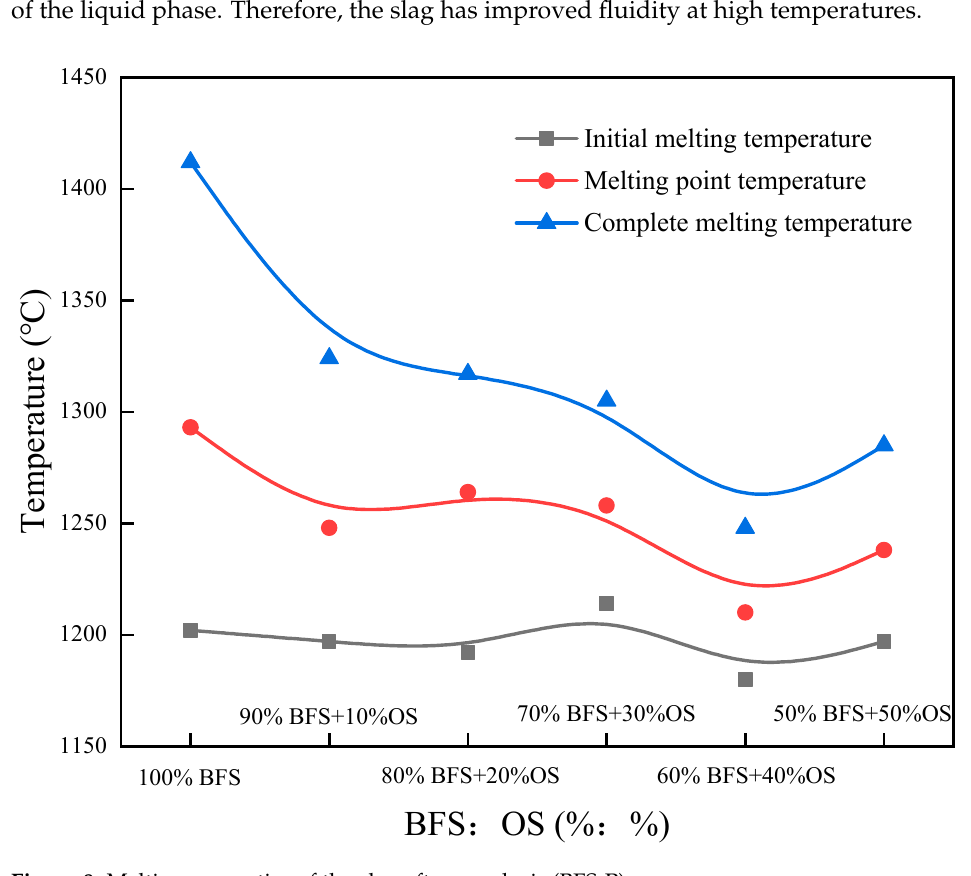
Figure 8. Melting properties of the slag after pyrolysis (BFS-P).